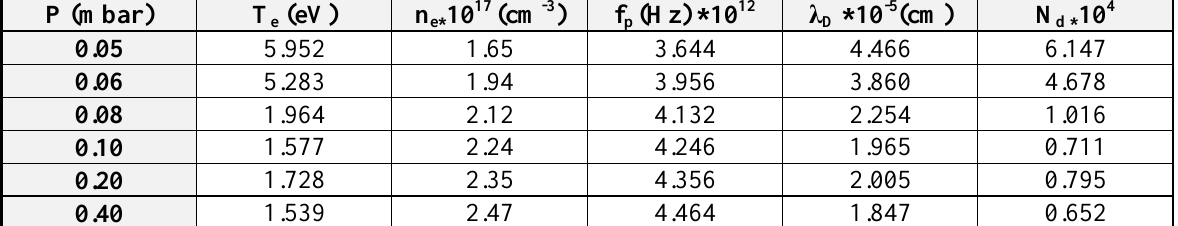
Table 1: Plasma parameters for RF plasma in Ar with different working pressure. P (mbar)